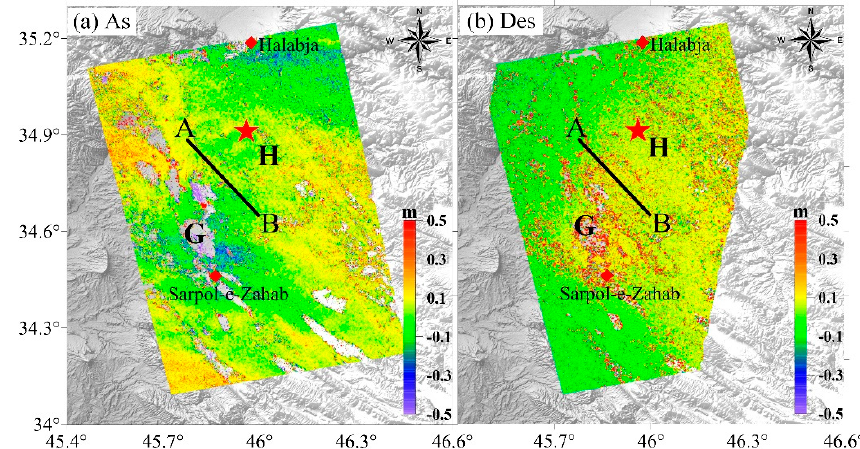
Figure 3. The along track deformation maps derived from MAI (multiple aperture InSAR) processing. ( a ) and ( b ) derived from ascending and descending ALOS-2 MAI processing, respectively. The red star represents the epicenter of the mainshock; The red solid squares represent the city Halabja and Sarpol-e-Zahab. The black line AB is the deformation bound.